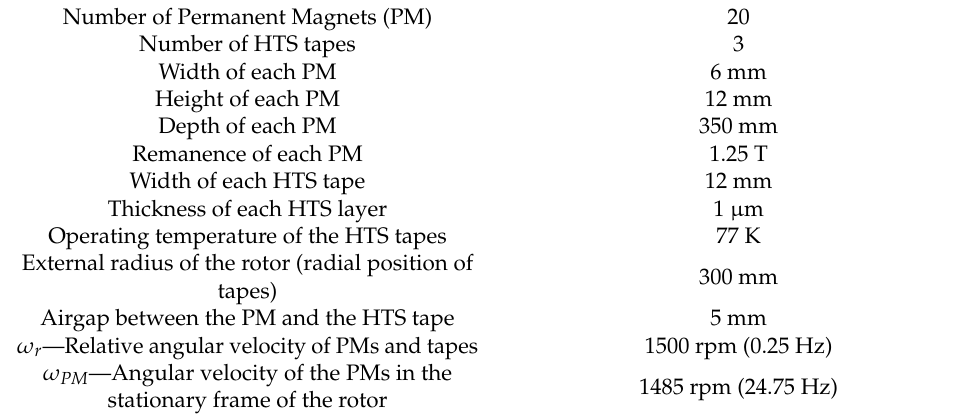
Table 2. HTS dynamo